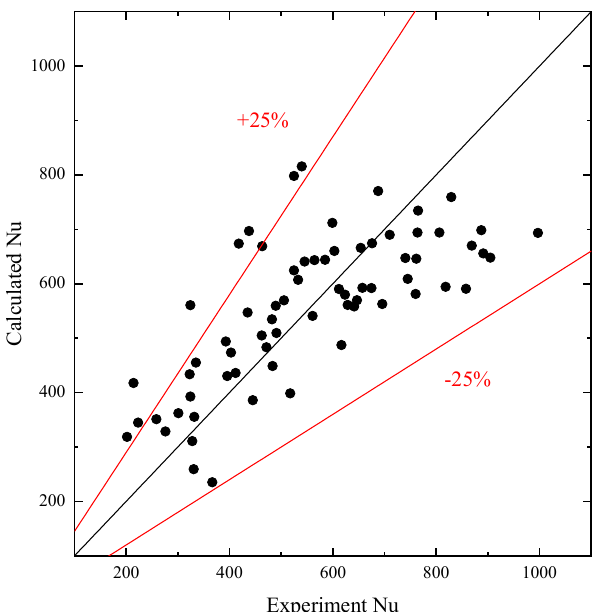
Figure 26. Comparison of fitted and experimental values when fitting the correlation equation using Re, Pr and h/D.